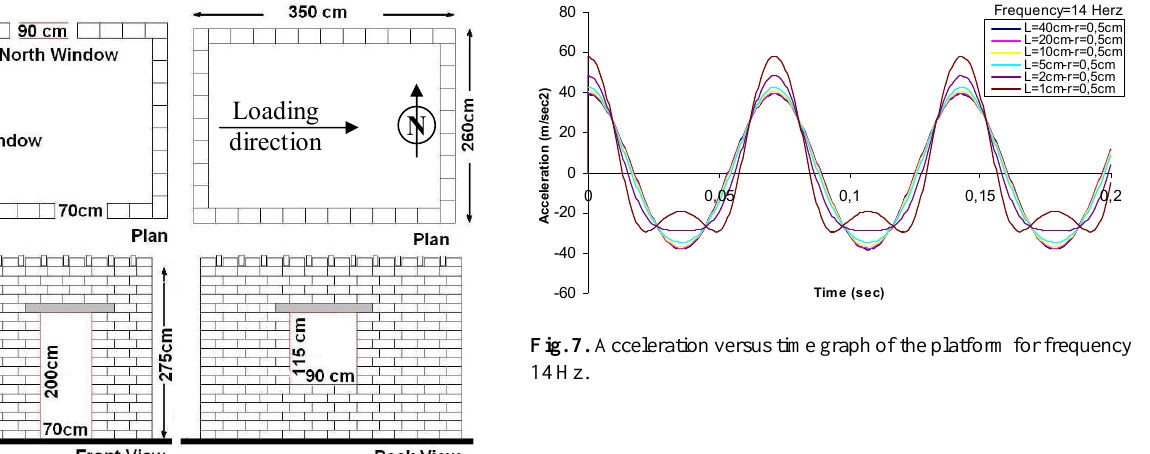
Fig. 6 Geometry of model house During the testing a constant amplitude sinusoidal displacement was applied. Maximum velocity and acceleration were linear functions of w and w 2 . The frequency of the motion was started from low frequencies and increased with time. As the frequency of the motion was increased, also acceleration of the table was increased remembering the amplitude of the motion was constant during the testing. The failure instant and